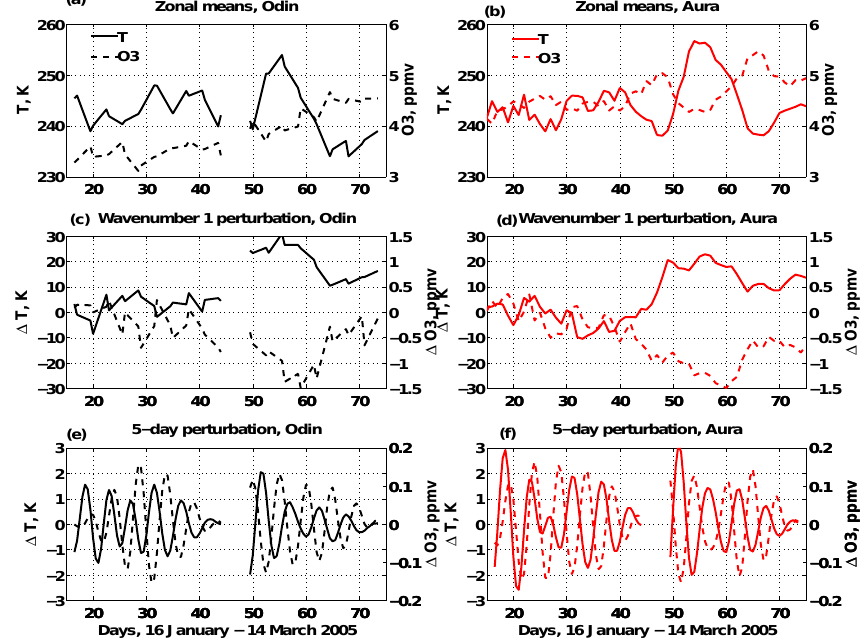
Fig. 16. Zonal means, wavenumber one and 5-day perturbations in temperature (solid line) and ozone (dashed line) at 40–42km, at 60 ◦ N from Odin SMR data (left-hand panel, black lines) and Aura MLS data (right-hand panel, red